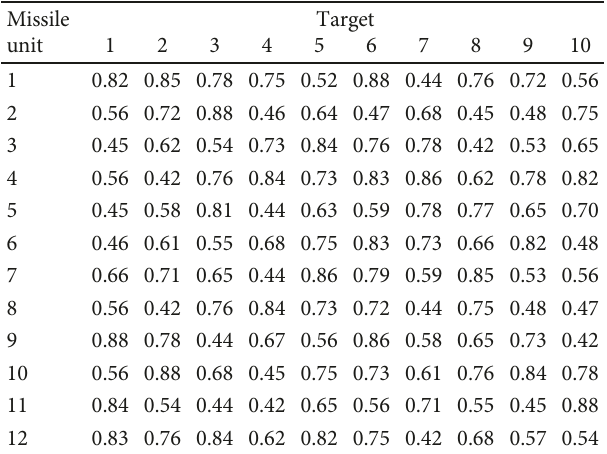
Table 16: Missile damage